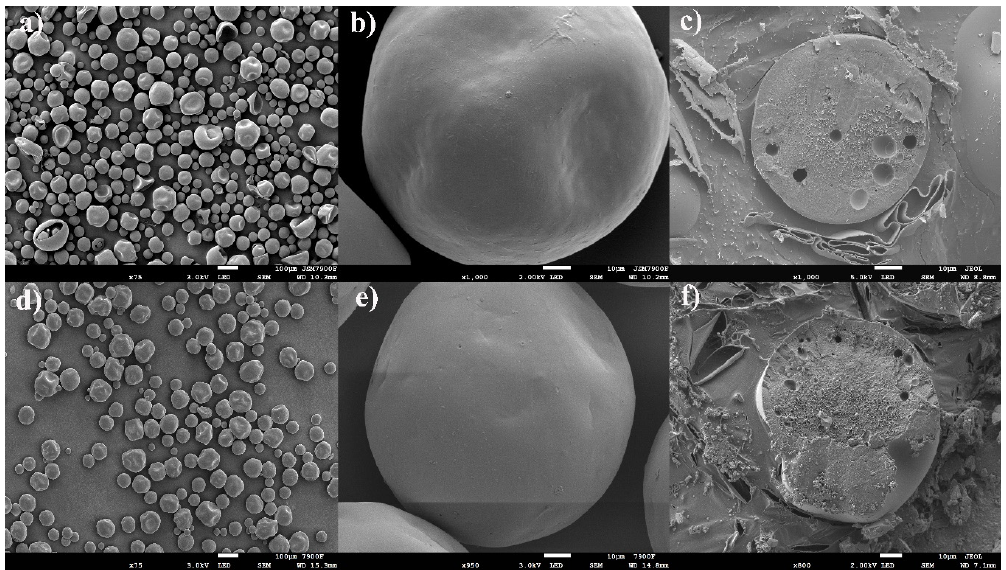
Figure 6. The morphology and relatively tight internal structure, Vivitrol ® : ( a ), ( b ) and ( c ); GNM: ( d–f